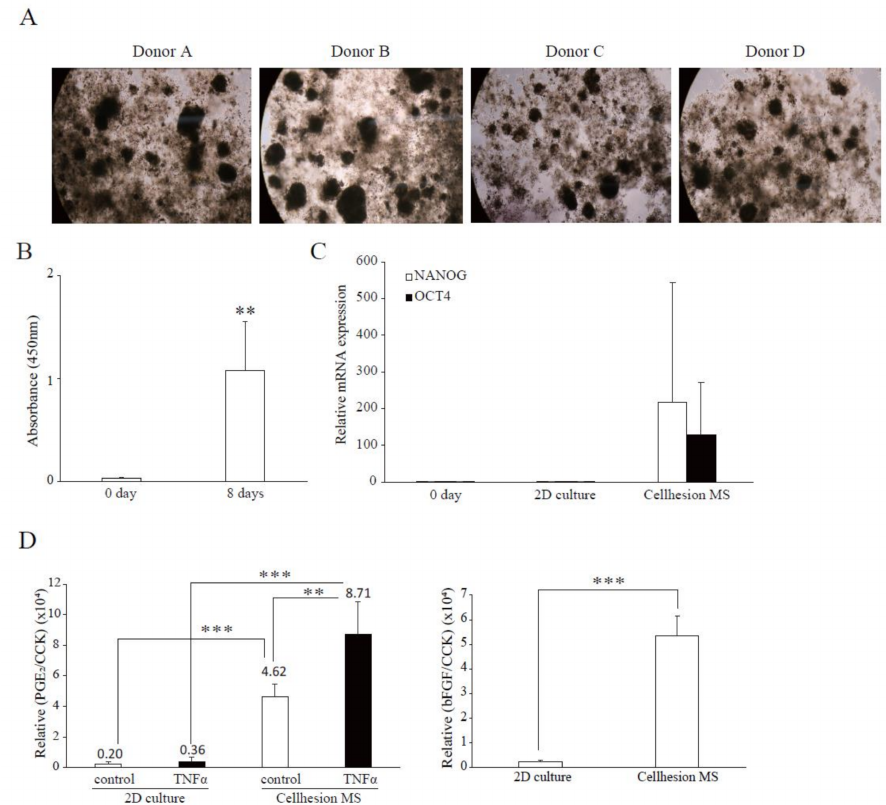
Figure 4. Confirmation of characteristics of Cellhesion ® MS culture, using UCMSCs from donors. ( A ) Images of cell morphology for each donor. ( B ) The number of primary UCMSCs from donors increased. The number of primary UCMSCs was measured using an ATP assay. ** p < 0.01, compared with day zero. ( C ) The expression levels of NANOG and OCT4 mRNA in UCMSCs on Cellhesion ® MS increased, compared with day zero and monolayer culture. The expression levels of NANOG and OCT4 mRNA in UCMSCs were determined by real-time RT-PCR and normalized to GAPDH mRNA levels. ( D ) The secretion levels of PGE 2 and bFGF from UCMSCs cultured with Cellhesion ® MS increased, compared with monolayer culture. The secretion levels of PGE 2 and bFGF from UCMSCs were measured by ELISA and normalized with a CCK assay. ** p < 0.01, *** p < 0.001, compared with control or TNF α . Data show mean averages ± SD for four independent